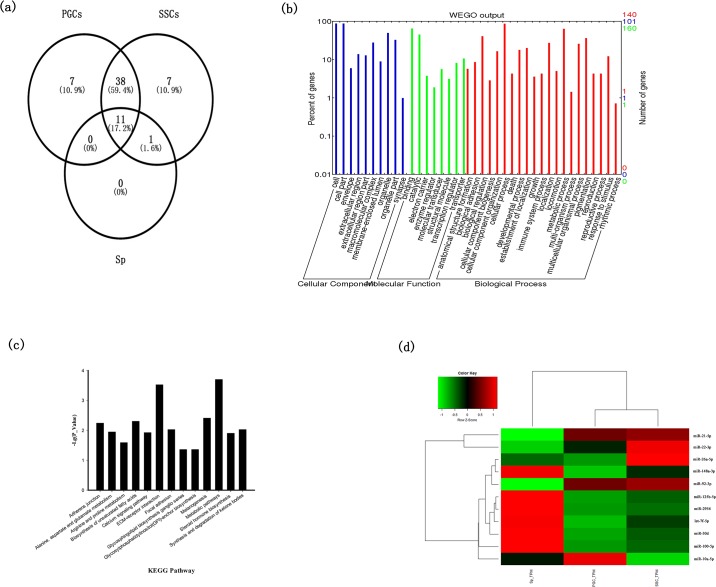
Analyses of the most abundant mature miRNAs in the PGCs, SSCs, and Sp libraries.(a) Venn analysis of the group with counts ≥10000. (b) GO analysis of the target genes of 11 common miRNAs. (c) KEGG pathway analysis of the target genes of 11 common miRNAs. (d) Expression patterns of 11 common miRNAs in the three types of cells. Red indicates up-regulated; green indicates down-regulated.